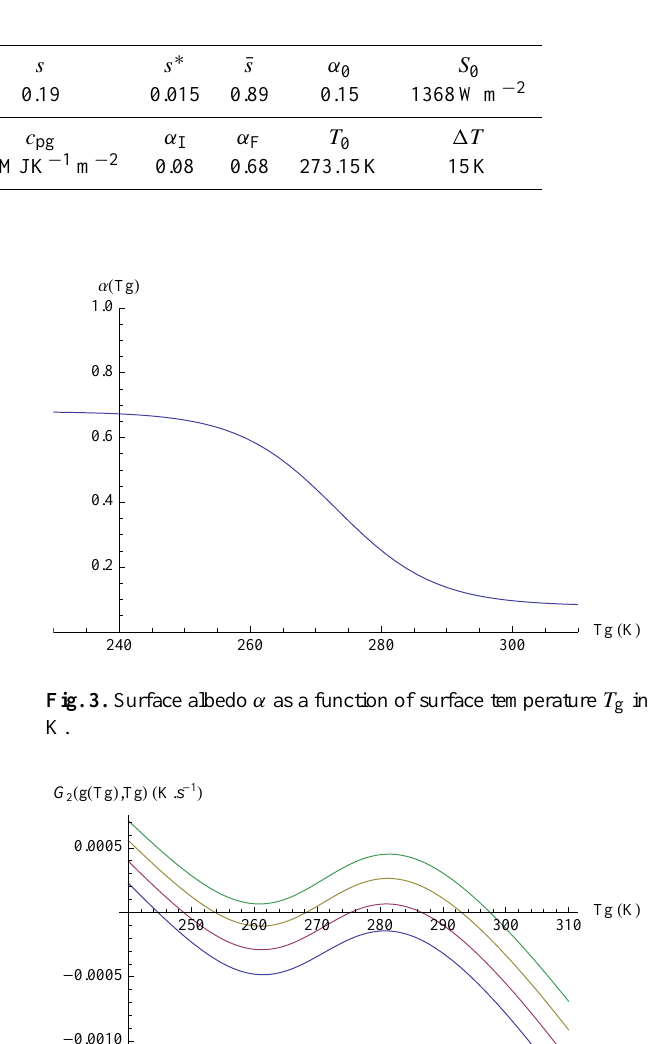
(e.g. 1.1 S 0 ), the only equilibrium is found on the ice-free branch T P g